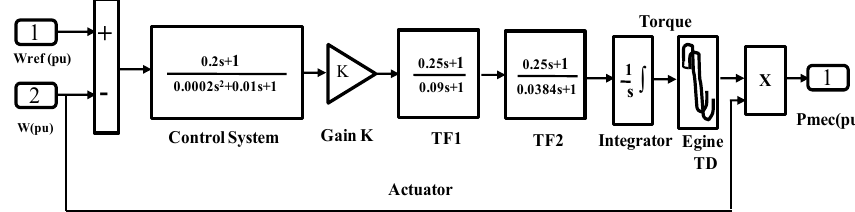
Figure 6. Schematic diagram of a diesel generator.